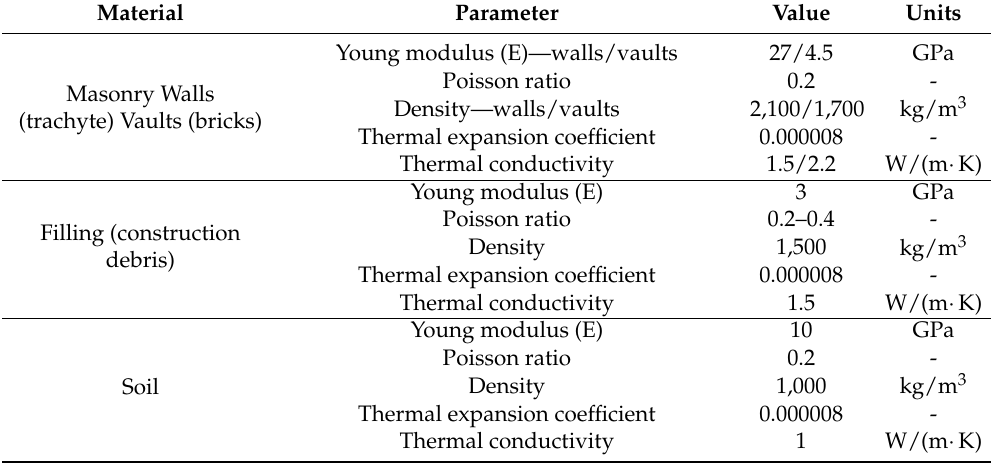
Table 1. Material properties used for numerical analysis. The mechanical characteristics were experimentally obtained ( in-situ non-destructive testing and destructive testing in laboratory) where possible (accessible parts of the structure—wall and vault masonry), or derived (for inaccessible parts of the structure—soil and filling material) from the current national standards ( Č SN ISO 13822, Č SN EN 1996-1-1 and Č SN EN 1997-1).